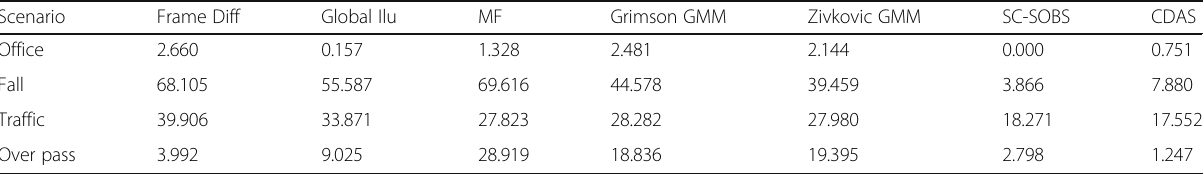
Table 10 Comparisons of MR of the competing methods over tested scenarios Scenario